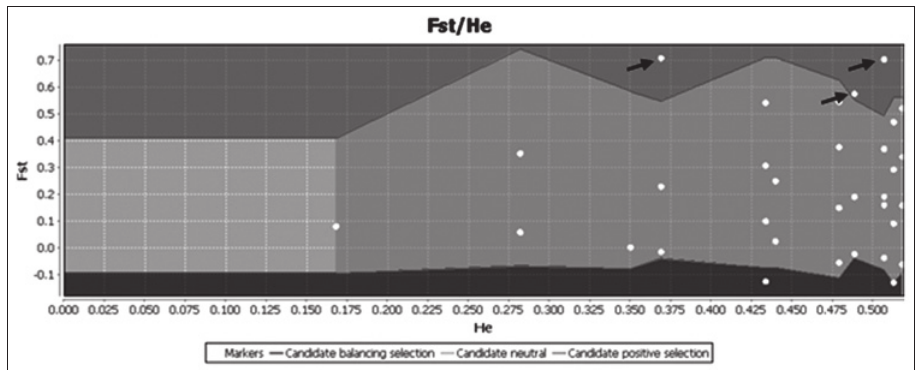
Figure-5: Graphical plot produced by Mcheza software of F values against heterozygosity (H ) for each of the 1890 ST e amplified fragment length polymorphism (AFLP) loci . The lower and higher zones represent the 0.5% and 99.5% confidence intervals, respectively. Loci in the semi-dark gray zone above the 99.5% are regarded as positive outlier loci. Each dot indicates an AFLP locus , loci scored the same value appears as one Table-3: Genetic differentiation through AMOVA of M. cephalus based on the AFLP loci dataset. Source of df SS Variance Percentage variance components of variation